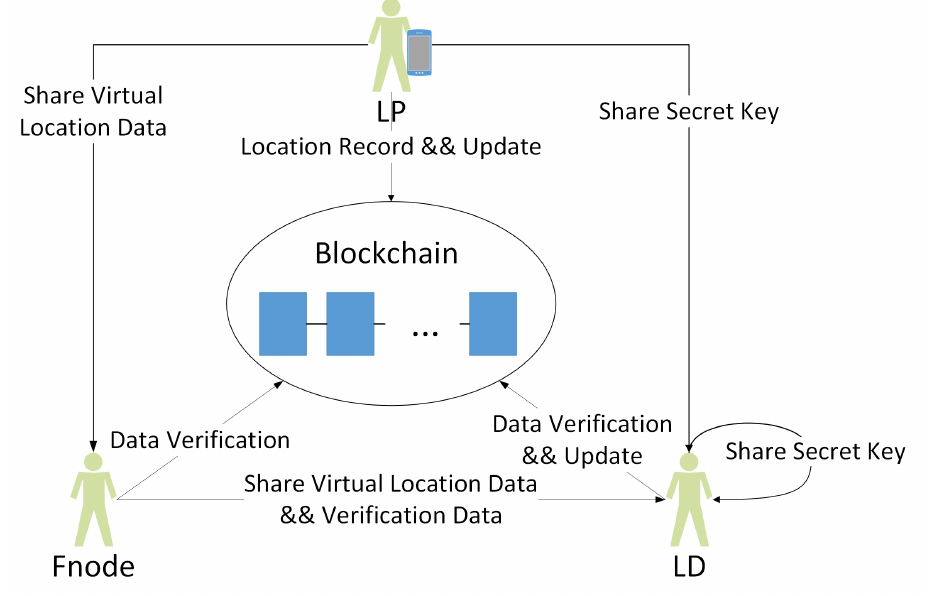
Figure 2. Conceptual overview of the proposed